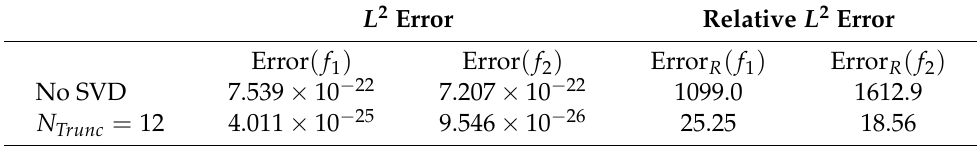
Table 6. Absolute and relative errors. Influence of the application of the regularization strategy.